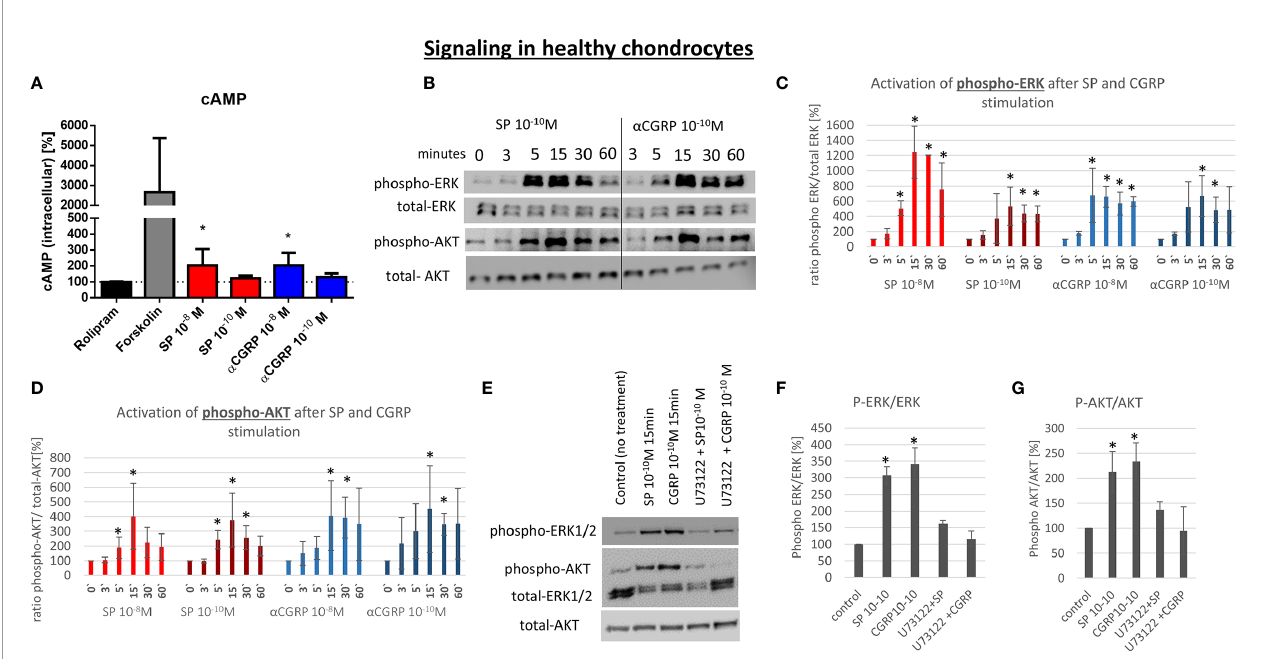
FIGURE 6 | Effect of SP and a CGRP on signaling in non-OA chondrocytes. Chondrocytes were treated with either 10 -8 or 10 -10 M SP or a CGRP for 3, 5, 15, 30 and 60 minutes and then compared to the respective untreated control cells. (A) Level of cAMP was detected via ELISA. Cells were pre-incubated with Rolipram (phosphodiesterase 4 inhibitor) to avoid cAMP degradation, and then treated with SP, a CGRP or Forskolin (positive control for cAMP induction). The graph shows the relative amount of cAMP in relation to Rolipram-incubated cells (dotted line = 100%) in non-OA chondrocytes. n = 3. (B) Representative Western Blot images indicating phospho-ERK1/2 (~ 44/42 kDa), ERK1/2 (~44/42 kDa), phospho-AKT (~60 kDa) and AKT (~60 kDa) protein signals after 0, 3, 5, 15, 30 and 60 minutes of neuropeptide stimulation in non-OA chondrocytes. (C, D) Ratio of phospho-ERK1/2 to total-ERK1/2 and phospho-AKT to total-AKT protein concentration was determined densitometrically. Expression w/o stimulation (0 ’ ) served as control set to 100%; n = 3. (E) Representative Western Blot images of U73122 (= phospholipase C inhibitor) treated non-OA chondrocytes to verify G alpha q mediated AKT- and ERK1/2-signaling. (F, G) Ratio of phospho-ERK1/2 to total-ERK1/2 and phospho-AKT to total-AKT protein concentration was determined densitometrically. Expression w/o stimulation served as control set to 100%; n = 3; Results are means +/- SD; one sample t-test *p <